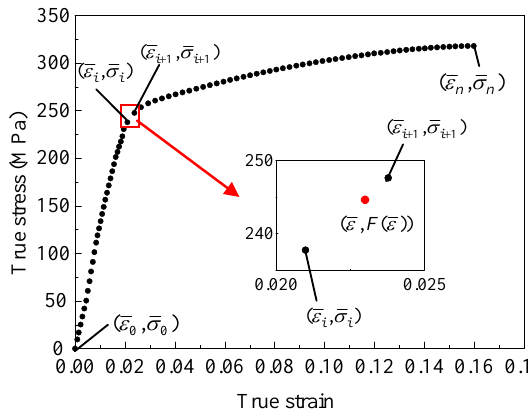
Figure 3. Original measured data (OMD) of stress-strain.